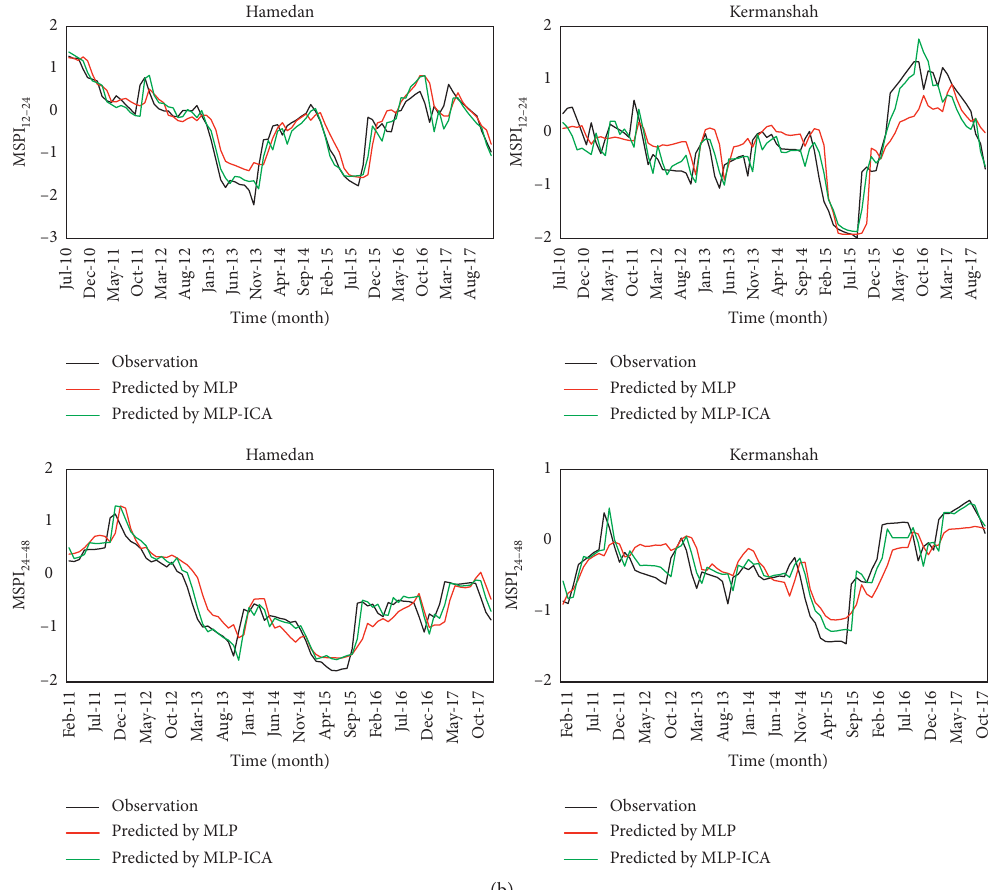
Figure 6: Time series plots of the observed and predicted values of MSPI in the test